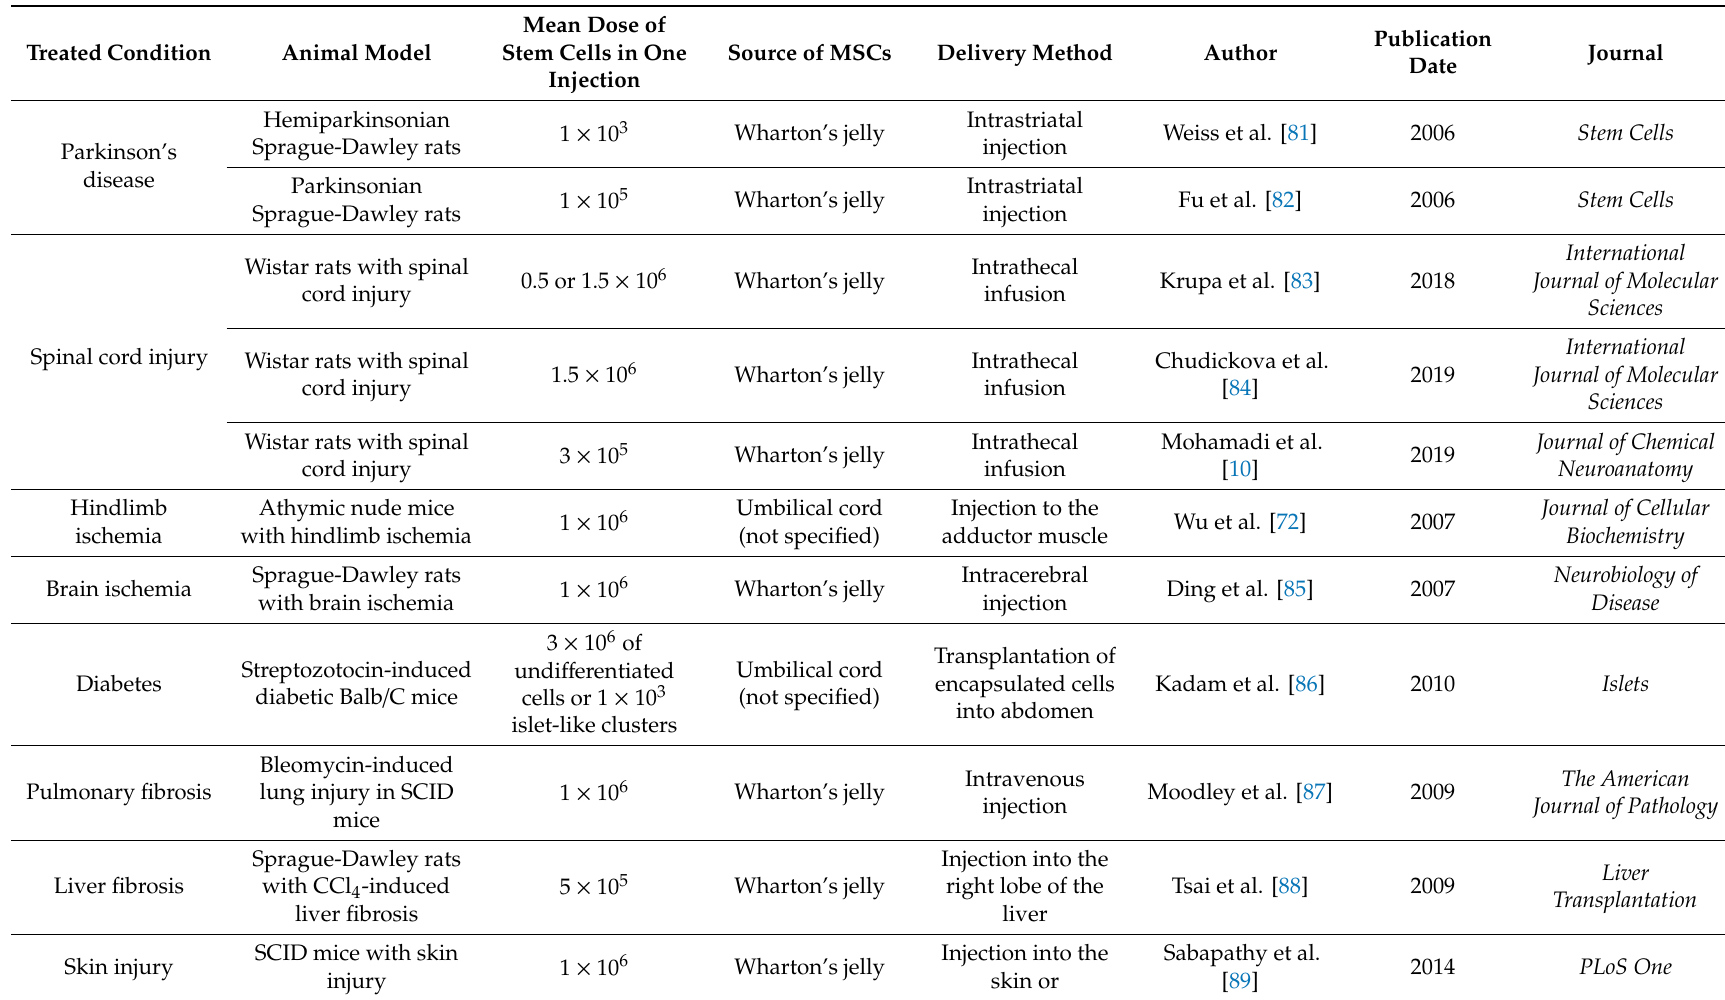
Table 1. Animal studies with the use of stem cells from human umbilical